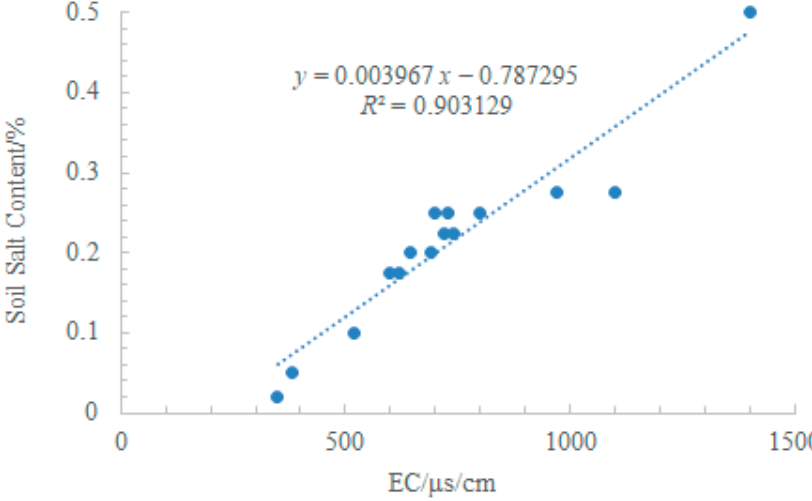
Figure 4. The relationship of soil salt content and conductivity.